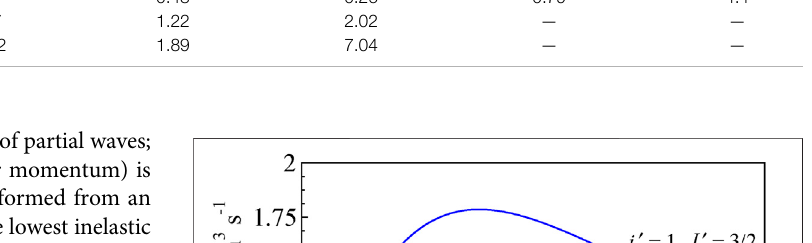
TABLE 1 | Comparison of the present CC cross section results with literature data. Collision energy E c.m (eV)